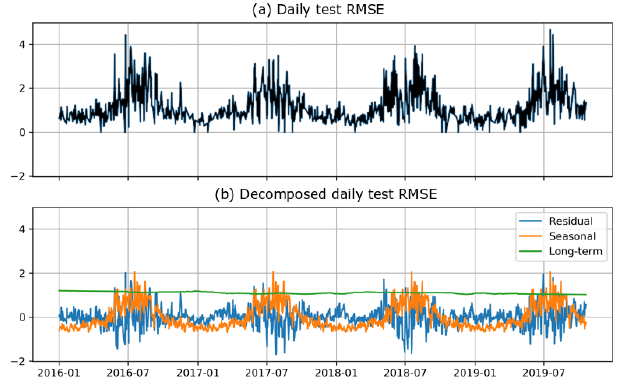
Figure 7. (a) Average daily test RMSE obtained from a five-fold cross-validation, (b) daily test RMSE decomposed into seasonal and long-term trends, and fluctuations from these two